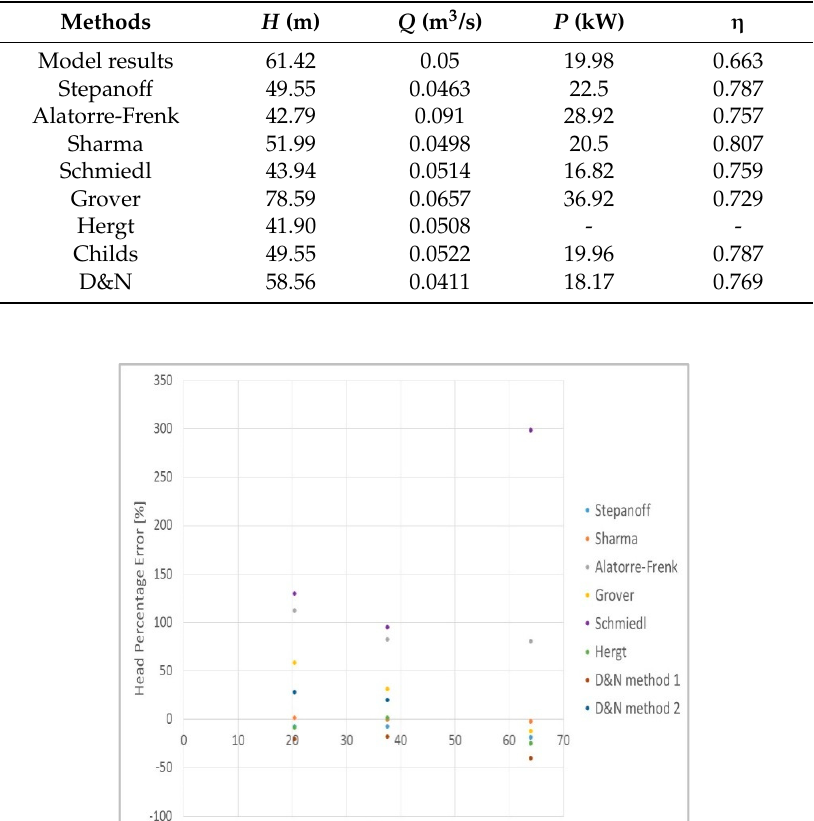
Table 4. Comparison for pump 1.